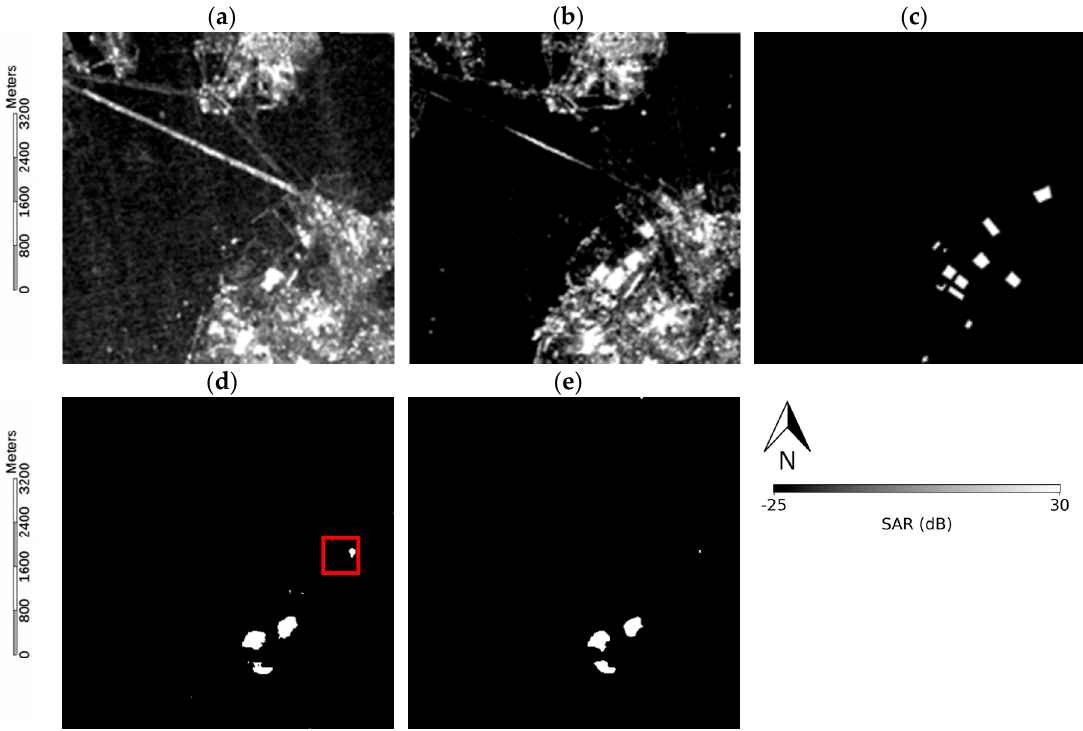
Figure 12. Result of the first Xiamen test site at 24 ° 28 ′ 35.28”N 118 ° 11 ′ 36.12”E. The size of each image is 6 × 6 km. ( a ) Time 1 SAR data; ( b ) Time 2 SAR data; ( c ) ground truth; ( d ) result of proposed model; ( e ) result of U-net.